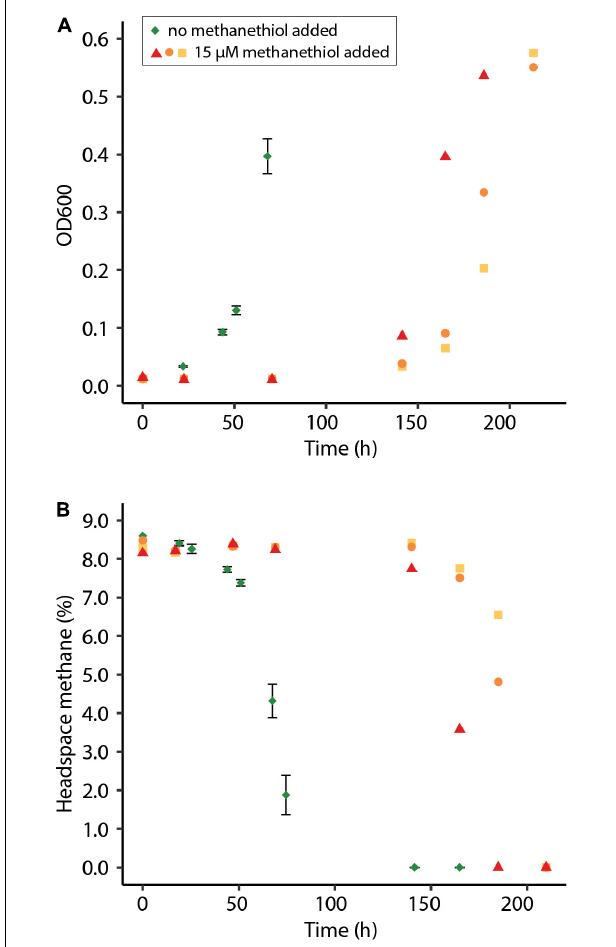
FIGURE 3 | (A) Optical density measured at 600 nm (OD 600 ) of methane-oxidizing Methylacidiphilum fumariolicum SolV cells in serum bottles and (B) the percentage methane in the headspace of the bottles over time. Green diamonds indicate average of positive controls to which no methanethiol was supplemented. Error bars indicate standard deviation ( n = 3). Red triangles, orange dots, and yellow squares indicate incubations to which 1200 nmol methanethiol was added at the start of the experiment, to create approximately 15 µ M methanethiol in the liquid. Methanethiol was depleted after 71 h. Experiments were performed in